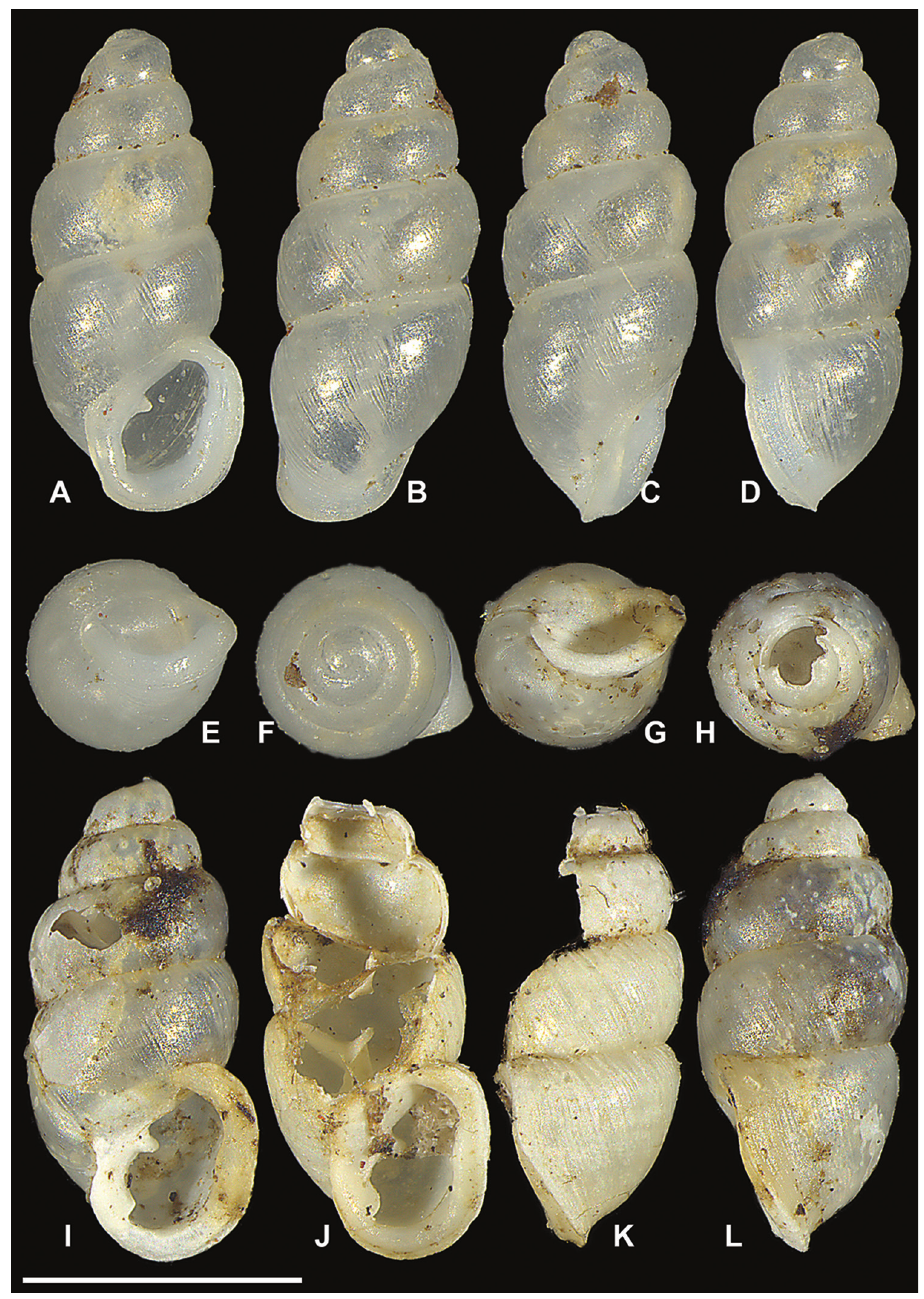
Figure 8. Comparative material, Carychium mexicanum Pilsbry, 1891 (AJC 2092) from Puebla, Mexico. A–L fresh shells collected proximal to topotypic locality (Orizaba, Mexico) A, I–J degrees of variation in apertural barriers. Scale bar 1